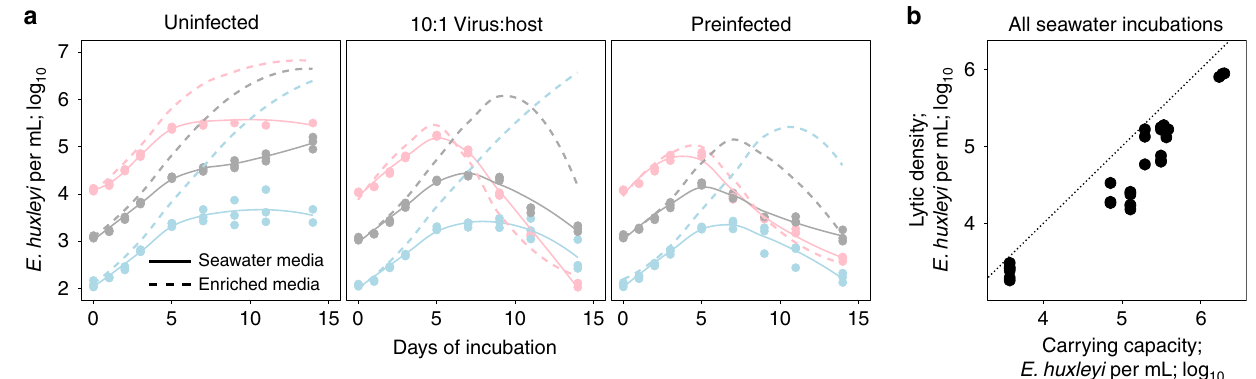
Fig. 4 Physiological stress triggers induction. a E. huxleyi growth curves in a representative experiment (Supplementary Table 1) in paired unenriched seawater (solid lines of best fi t and data points; n = 3 independent counts in each treatment per time-point) versus f /2 enriched media (dashed lines of best fi t from Fig. 1a) incubations in uninfected, 10:1 virus:host multiplicity of infection (MOI) co-incubations, and pre-infected hosts treatments. Similar